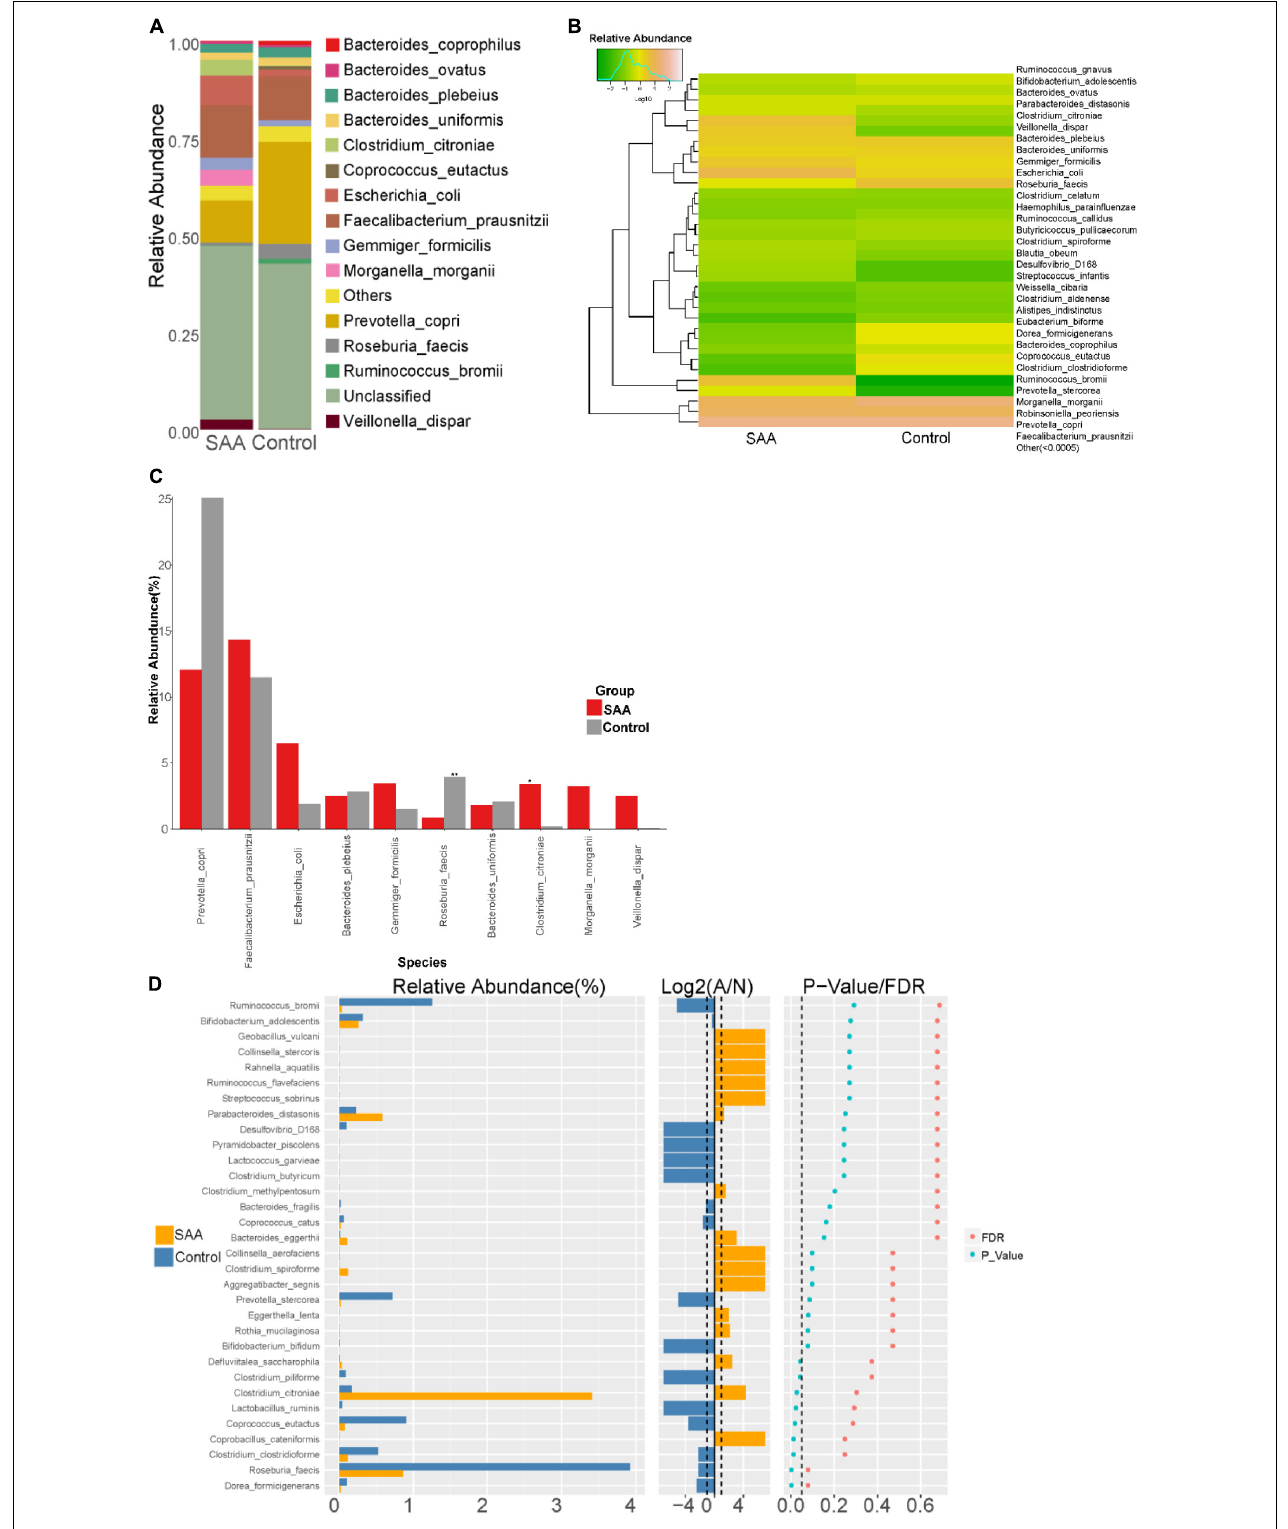
FIGURE 8 | Intestinal microbial compositions of the SAA and control groups at the species level. (A) Bar plot, (B) heatmap, (C) Wilcoxon rank-sum test results, (D) top 10 most abundant species.